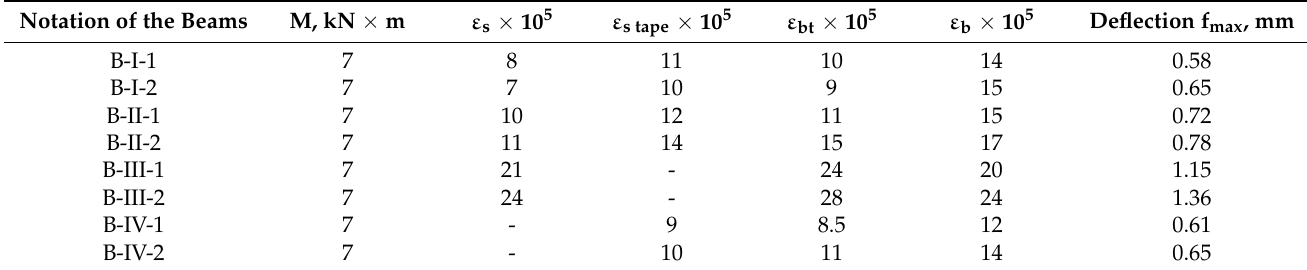
Table 1. The experimental results of beams at the initial stages of loading in the maximum bending moment